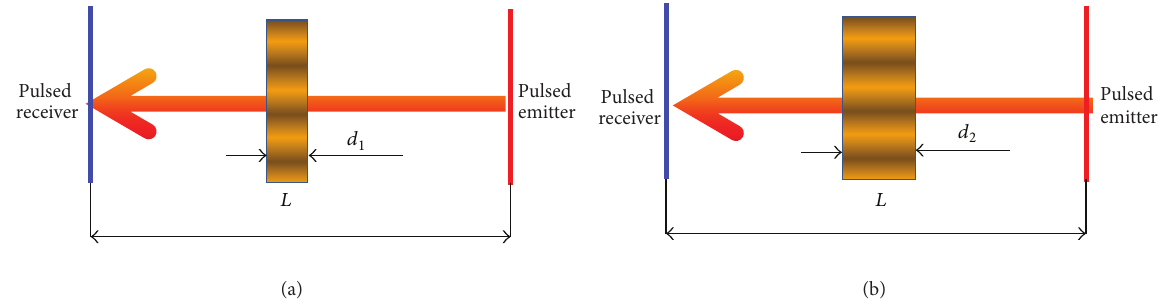
Figure 5: Diagram showing the geometry of the through-transmission mode with two samples in (a) thinner and (b) thicker samples.